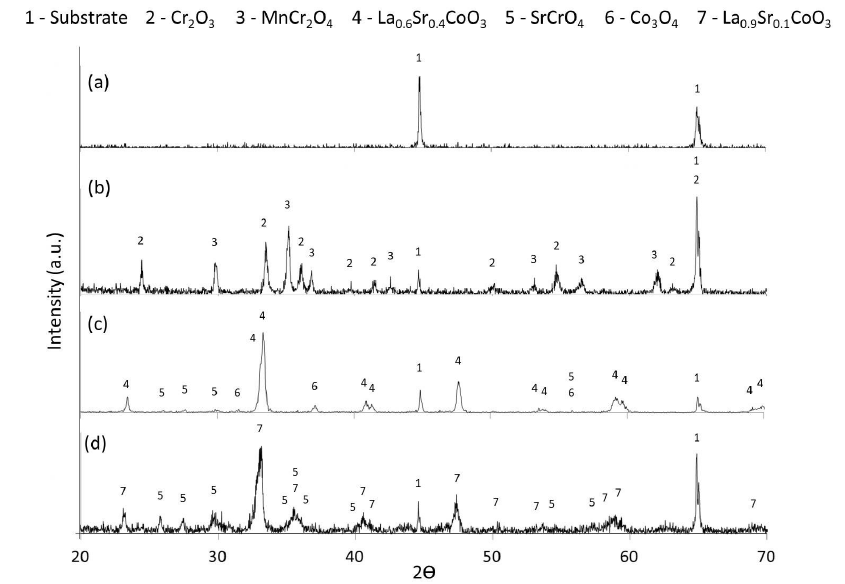
Figure 1. XRD patterns of (a) substrate, (b) oxidized substrate, (c) heat-treated LSC films and (d) oxidized LSC